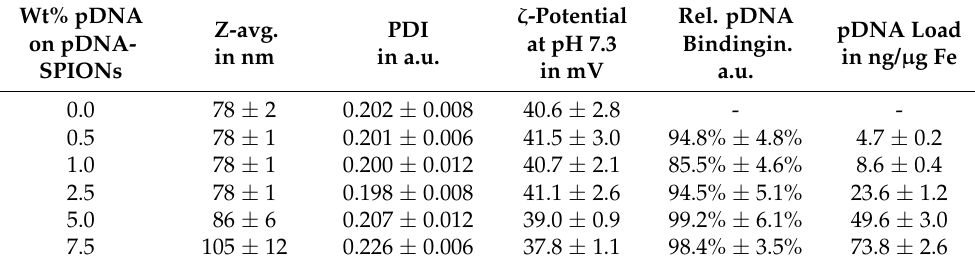
Table 1. Summary of particle parameters for pDNA-SPIONs with increasing pDNA